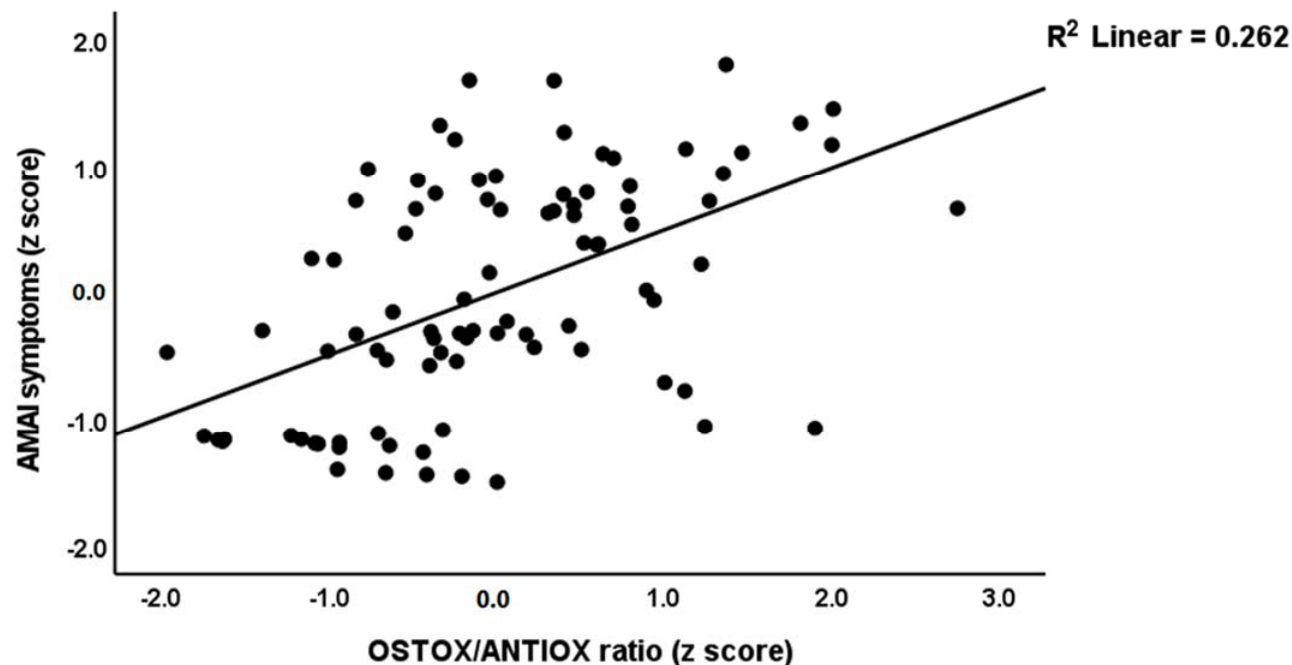
Figure 1. Partial regression plot of the acute methamphetamine intoxication (AMAI) symptom score on the oxidative stress toxicity/antioxidant (OSTOX/ANTIOX) ratio.